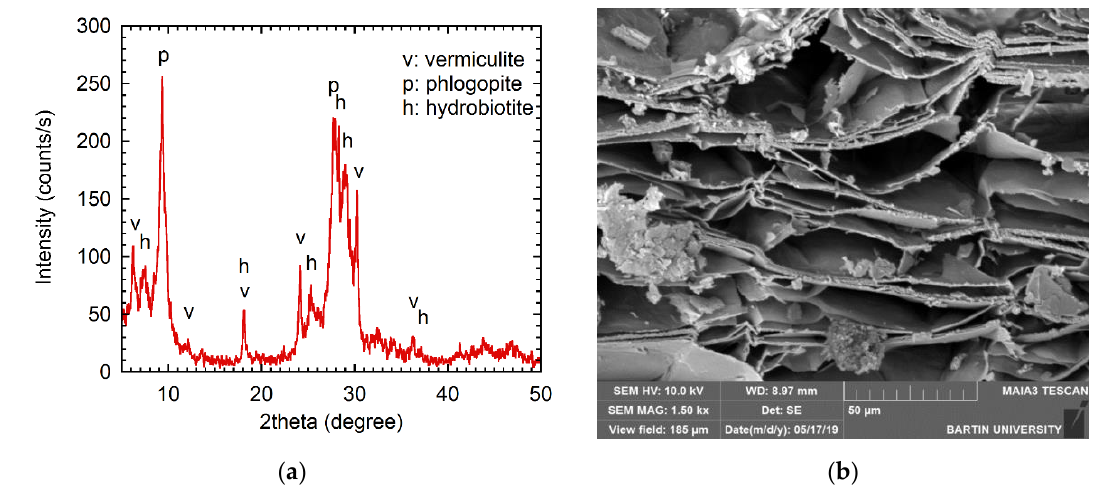
Figure 2. ( a ) XRD analysis and ( b ) SEM image of the expanded vermiculite.